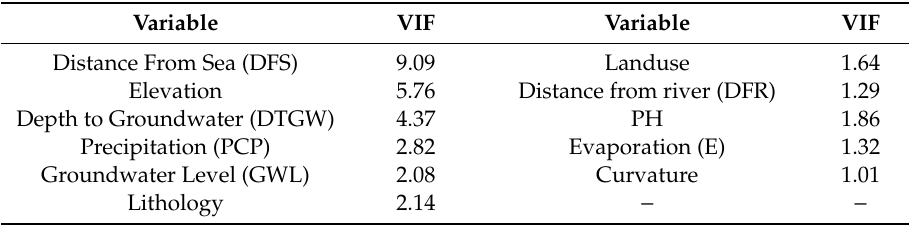
Table 2. Multicollinearity analysis using variance inflation factor